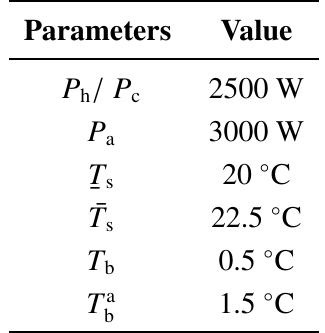
Table A2. Heat-pump parameters and thermostat